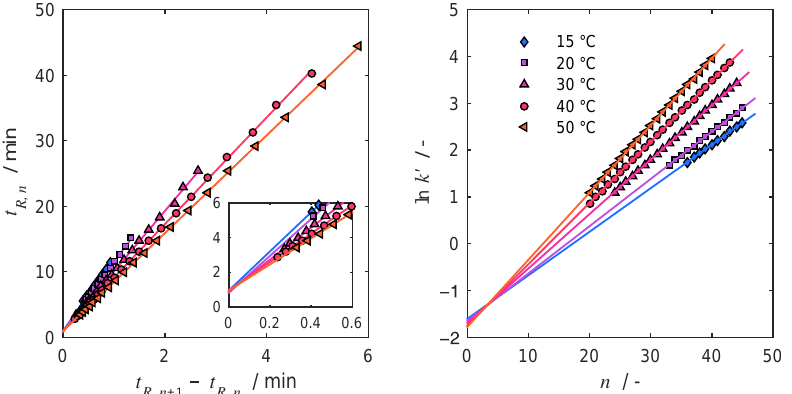
Figure 4. Evaluation of chromatograms exemplified for the temperature series for PEG1400 in Figure 1 (left) at 25 vol % ACN. Left —Determination of t 0 along Trathnigg’s method from the axis intercept in Equation (16). Right —Martin’s plot for the same data, underlining the linear dependency of ln k (cid:48) on n .